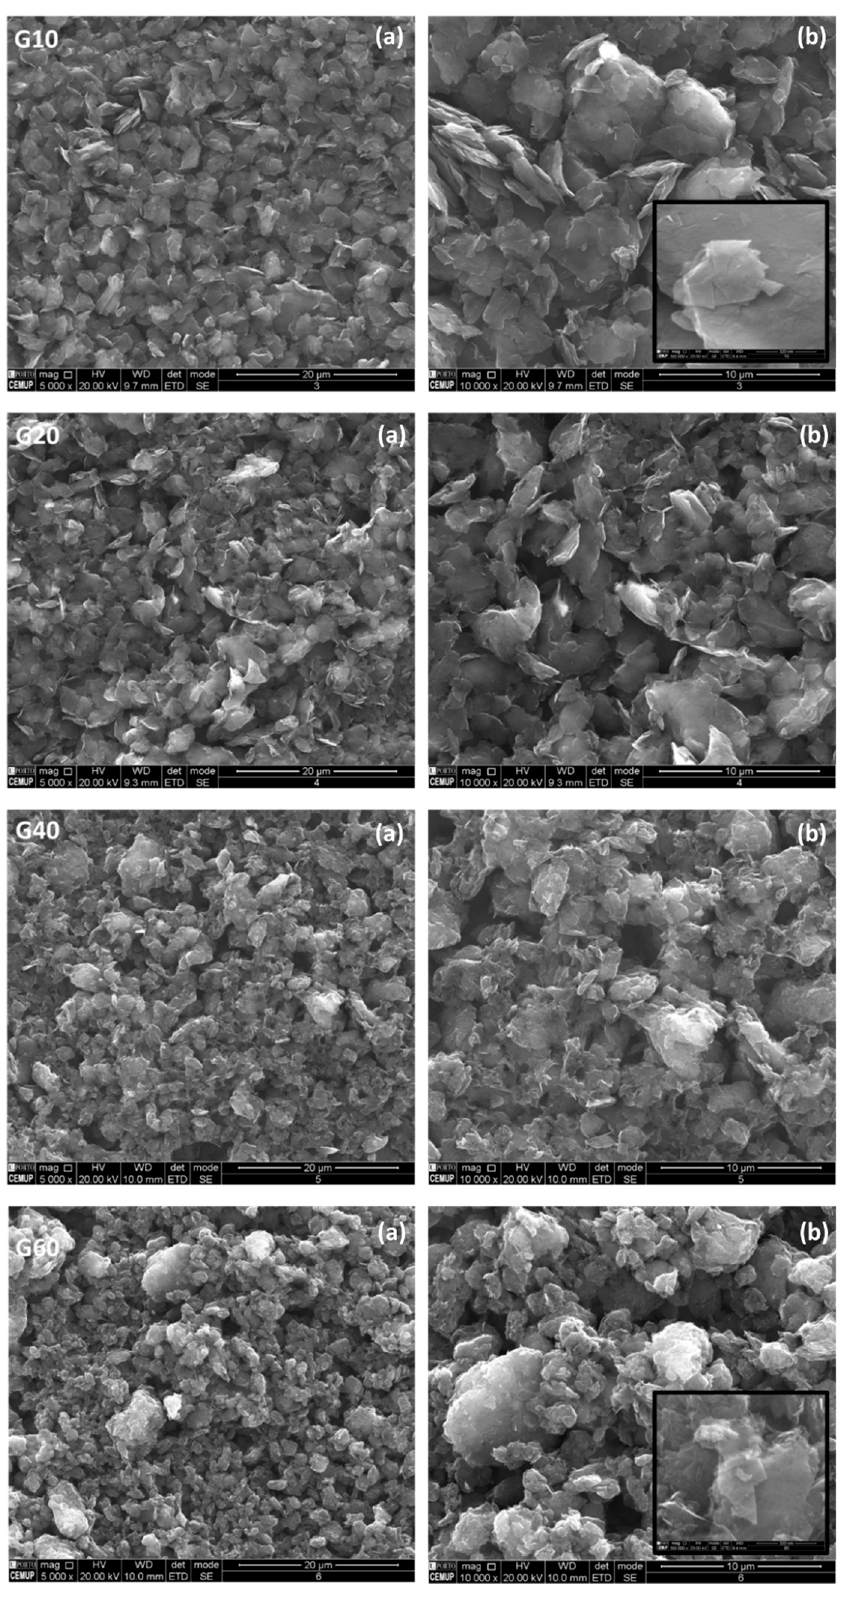
Figure 2. Electron microscopy images showing the structure of G10, G20, G40, and G60 samples with 5000× ( a ) and 10,000× ( b ) magnification. Inset images in Samples G10 and G60 present a 300,000× magnification.